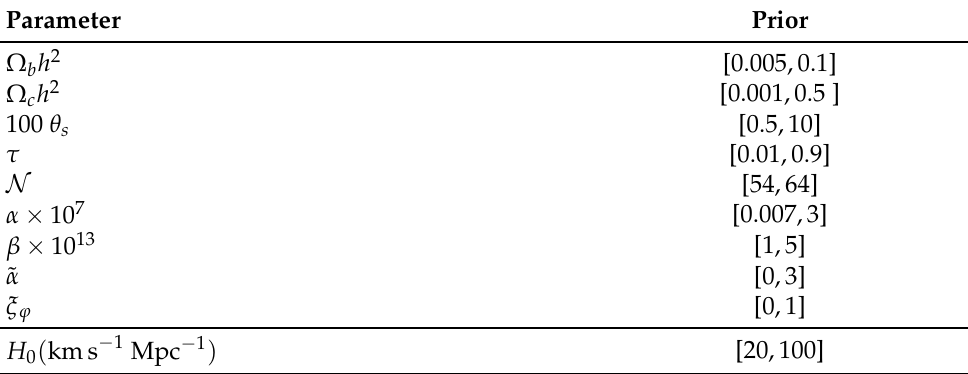
Table 1. Priors and constraints on the parameters of dark Higgs inflation model with curvature corrections adopted in the analysis. All priors are uniform in the listed intervals. We assume a flat